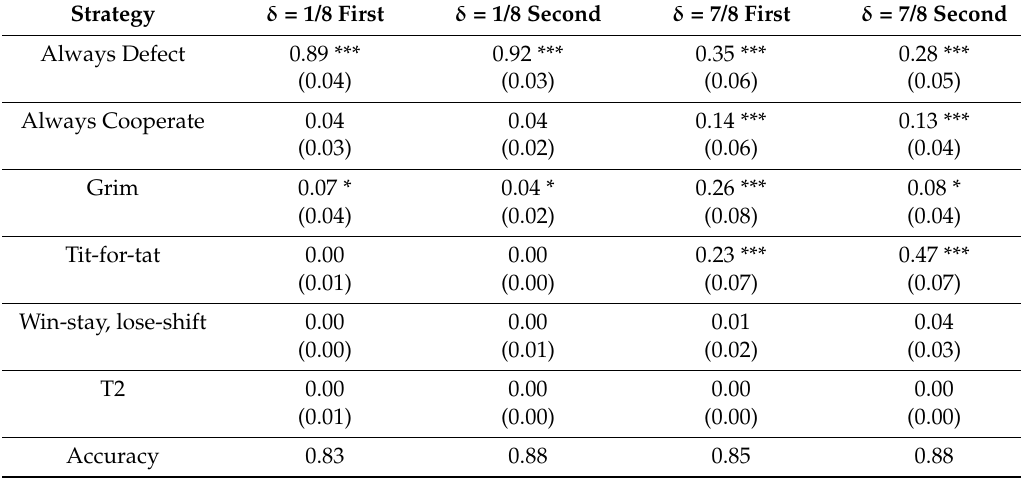
Table 3. SFEM results for each continuation probability, by order.